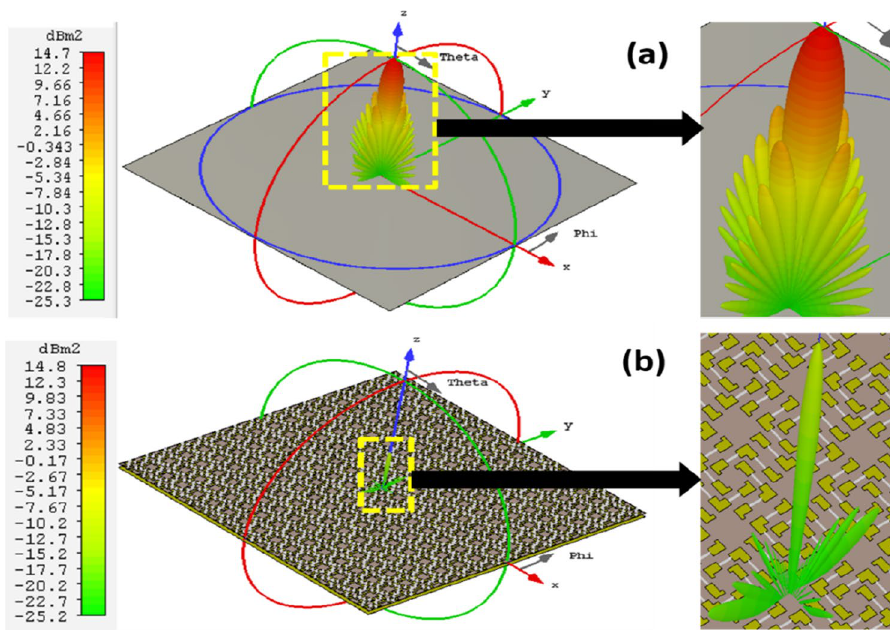
Figure 5. 3D RCS patterns of ( a ) planar PEC and ( b ) planar MA at 14.84 GHz under normal incidence.